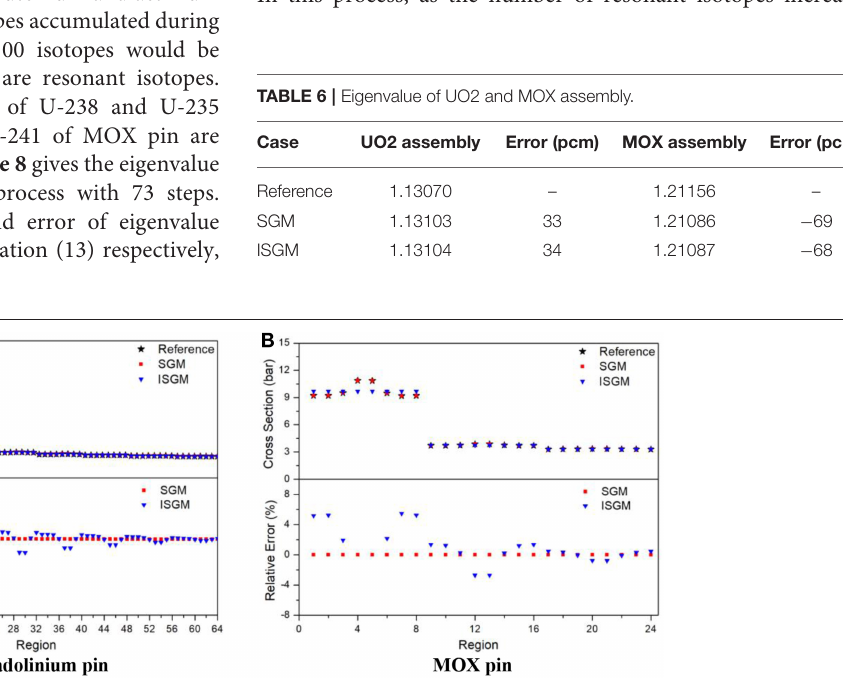
FIGURE 10 | Radial distribution of cross section for 5.72 eV to 7.34 eV of U-238. (A) Gadolinium pin, (B) MOX pin.